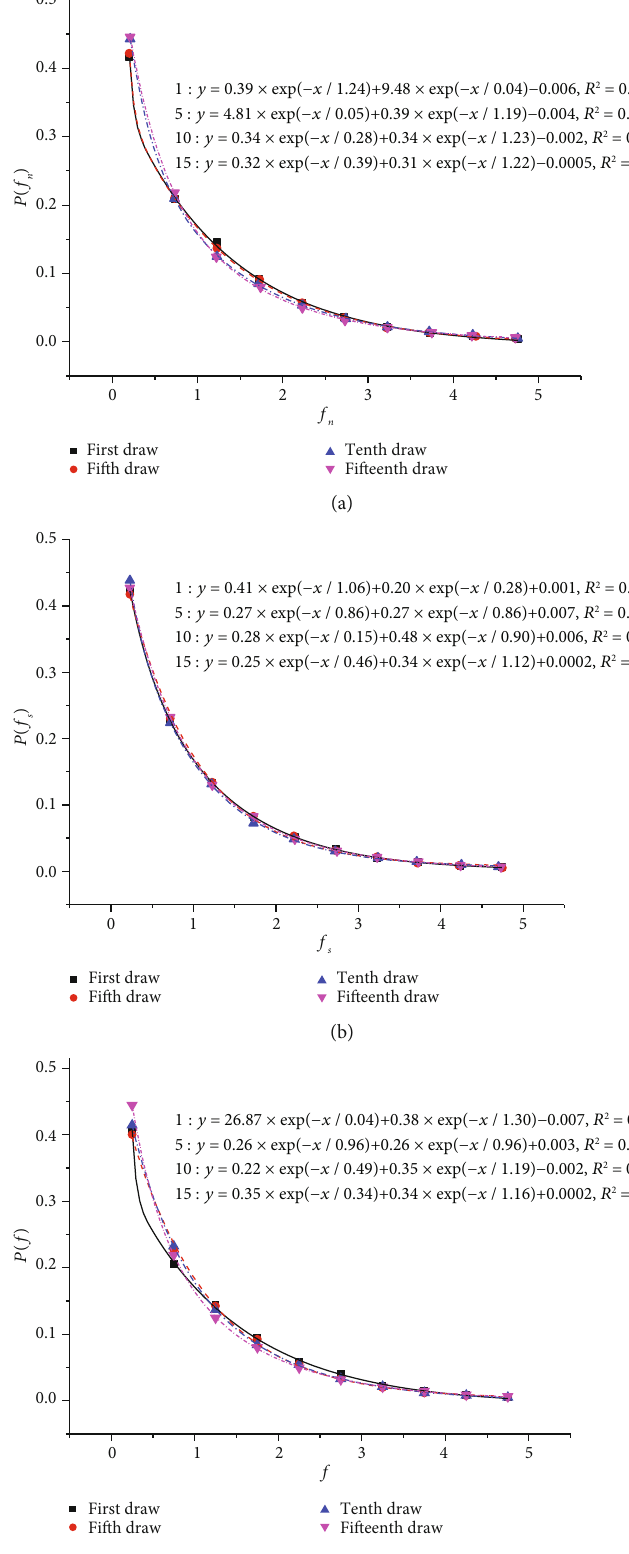
Figure 5: Probability distribution of the contact forces: (a) probability distribution of the normal contact forces; (b) probability distribution of the tangential contact forces; (c) probability distribution of the total contact